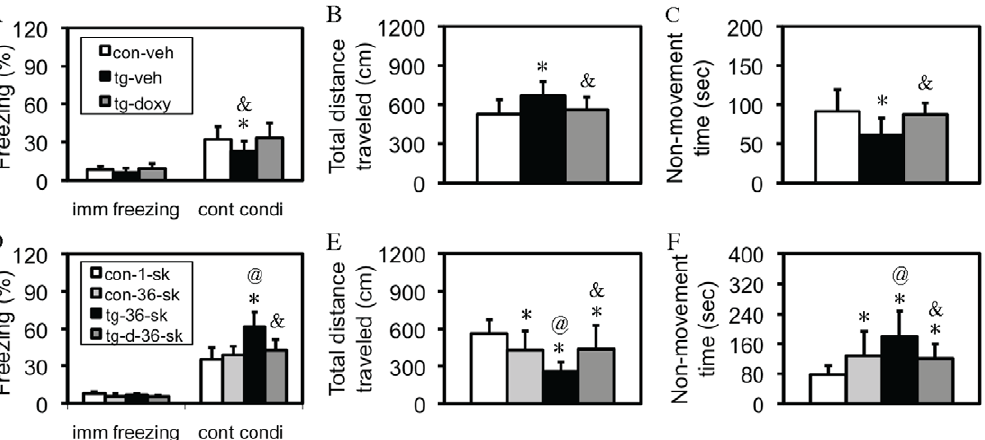
Figure 2. Bi-directional fear response in IF-CCKR-2 tg mice. (A–C) Fear response following 1 trial of footshock. (A) Freezing rate in immediate (imm) freezing following the US/CS coupling during training and freezing rate in contextual conditioning (cont condi) in the retention test. *, p , 0.05, compared to control mice-treated with vehicle (con-veh; n=11); & , p , 0.05, compared to tg mice-treated with doxy (tg-doxy; n=10). Tg-veh indicates tg mice-treated with vehicle (n=11). (B) Total distance traveled. *, p , 0.05; & , p , 0.05, the same group comparisons. (C). Total non-movement time. *, p , 0.05; & , p , 0.01, the same group comparison. All are post-hoc analyses following an one-way ANOVA. Data are expressed as mean 6 SD. (D–F) Fear response following 36 trials of footshock. (D) Freezing rate in immediate (imm) freezing following the US/CS coupling during training and freezing rate in contextual conditioning (cont condi) in the retention test. *, p , 0.001, compared to control mice-1-shock (con-1-sk; n=11); @ , p , 0.001, compared to control mice-36-shock (con-36-sk; n=11); & , p , 0.001, compared to tg mice-36-shock (tg-36-sk; n=11). Tg-d-36-sk indicates